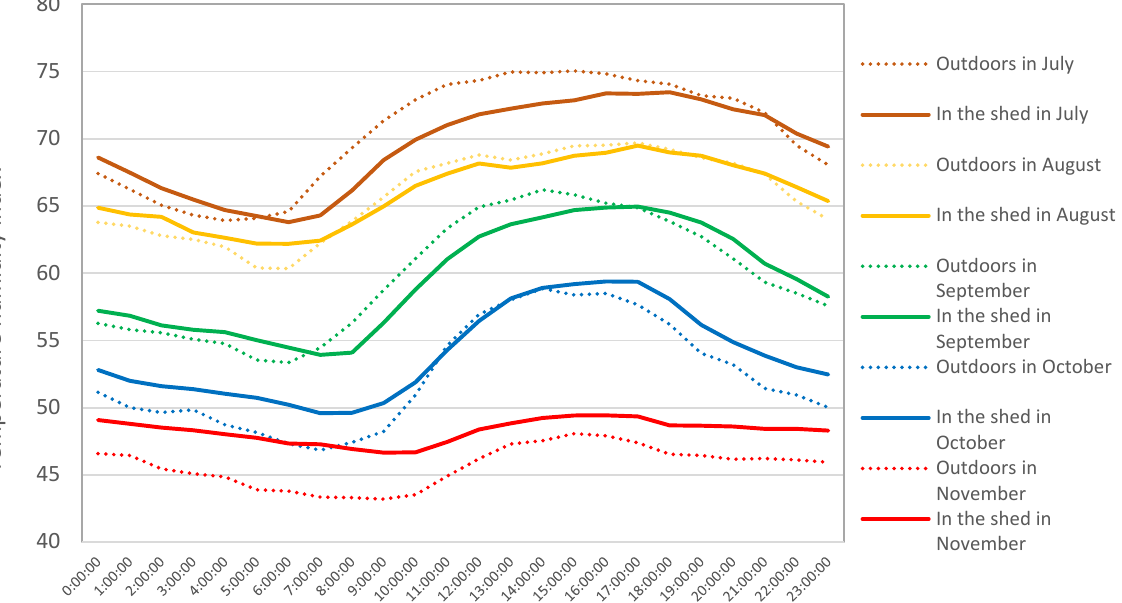
Figure 8. Average daily air temperature and humidity index change in the first decade of different months (7 cowshed).